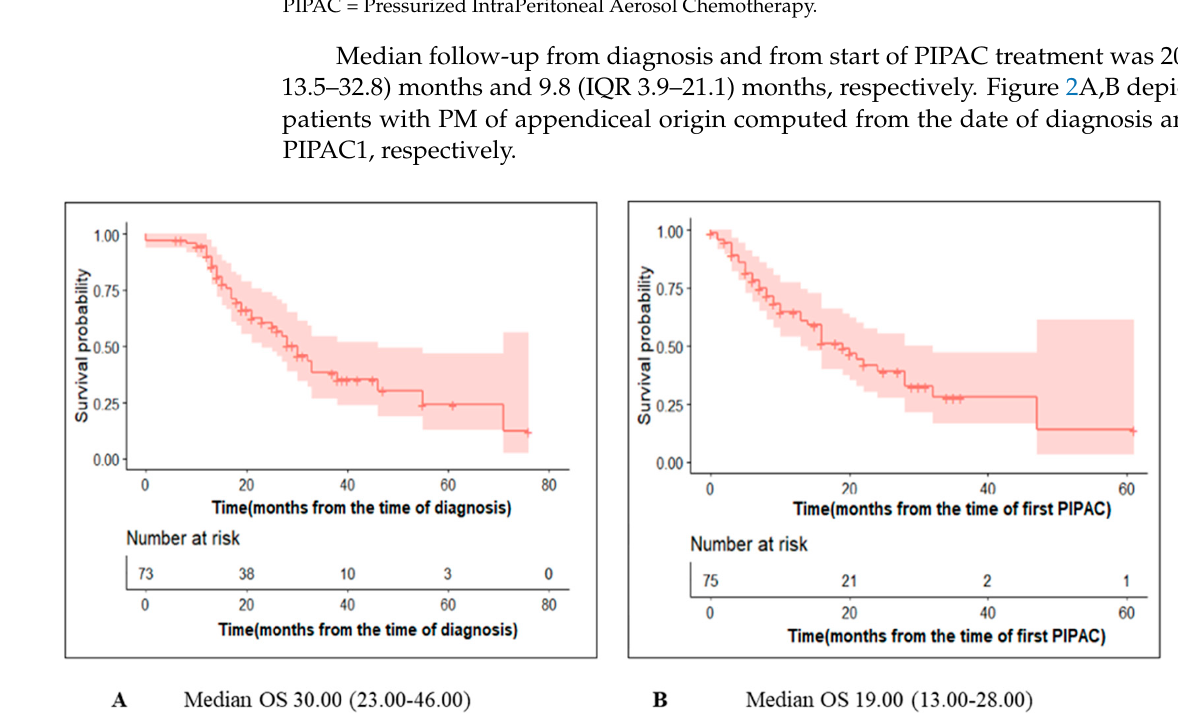
Figure 2. Survival of patients undergoing Pressurized IntraPeritoneal Aerosol Chemotherapy for peritoneal metastases of appendiceal origin. OS for the entire cohort from time of diagnosis ( A ) and first PIPAC ( B ). By protocol analysis for OS ( C ) from diagnosis and OS ( D ) from first PIPAC.